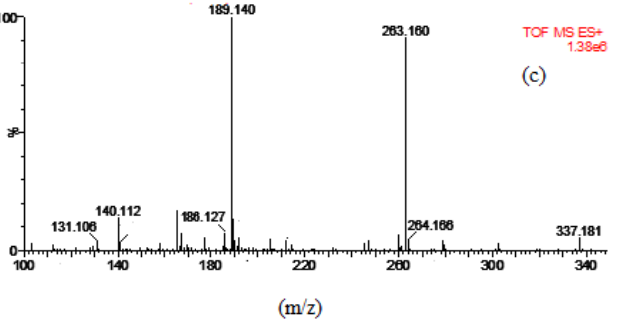
Figure 2. ESI-MS spectra of reaction media when ( a ) HAp-D, ( b ) HAp-S, and ( c ) HAp-R were used as the catalyst at 245 °C after 8 h of reaction.